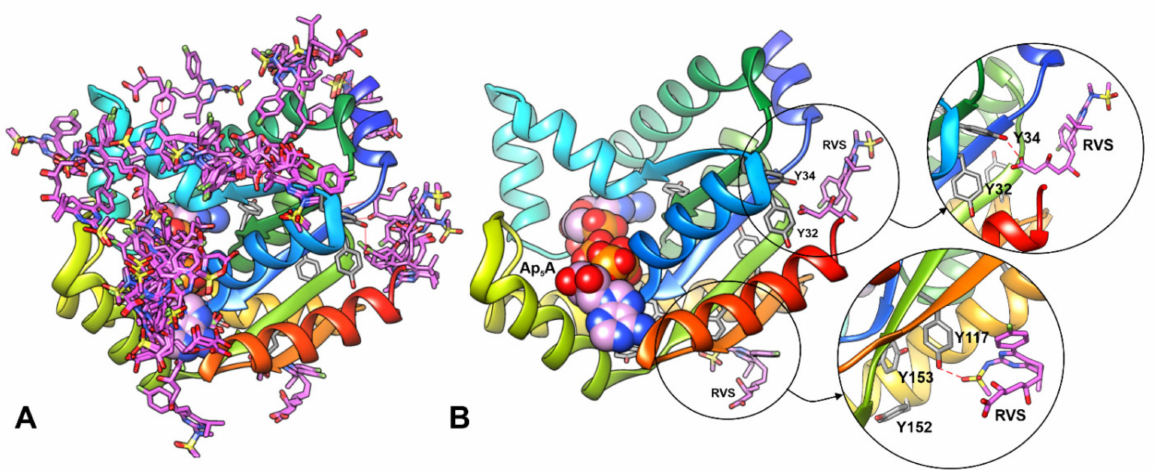
Figure 4. Results of blind docking of RVS to hAK1 performed with the SwissDock server. ( A ) All predicted binding sites for RVS (pink sticks) in hAK1. ( B ) The conformation of RVS at the selected possible binding regions in close vicinity of tyrosine residues. Ap 5 A is shown as spheres; possible hydrogen bonds are marked in red dashed line.